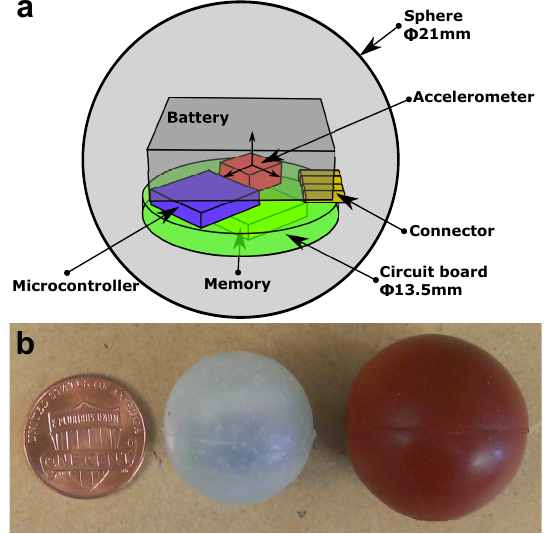
Figure 2. Structure of BIRD II ( a ) and the size comparison of a penny, BIRD II and BIRD I (from left to right) ( b